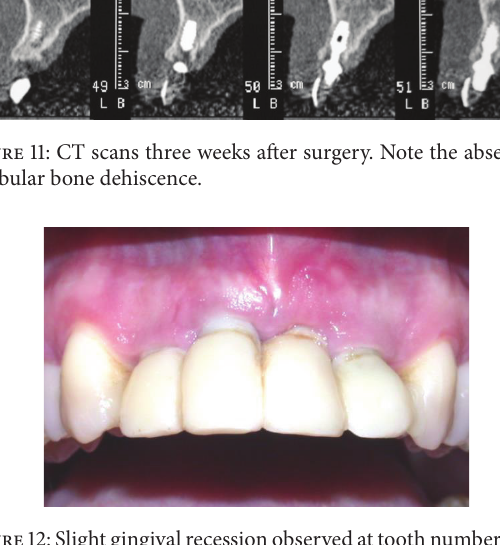
Figure 12: Slight gingival recession observed at tooth number 8, one week after surgery.